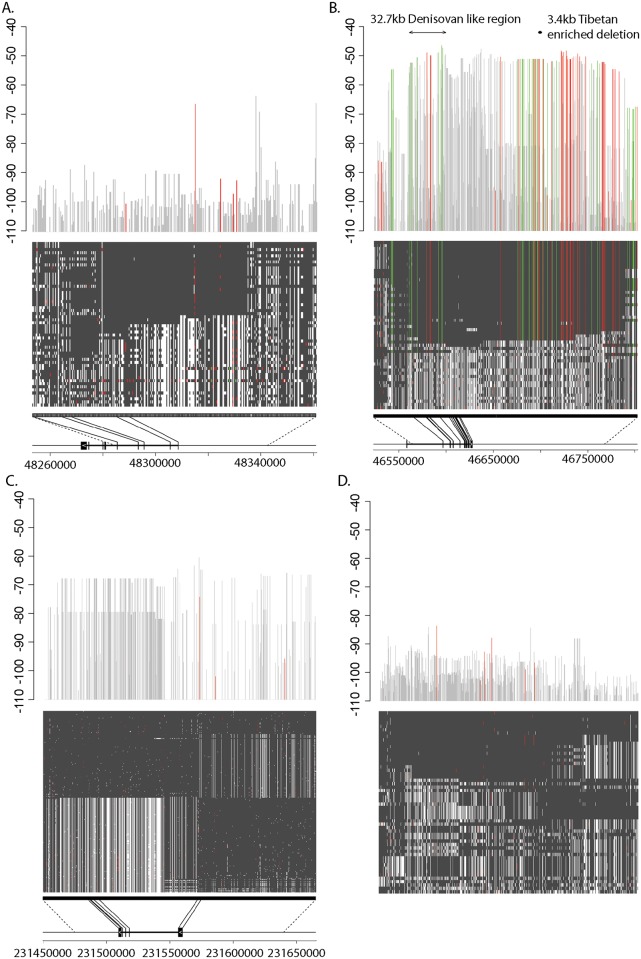
Haplotype map and CMS score in four genomic regions.The upper bar plot demonstrates the CMS values at each SNV. The middle plot shows the haplotype structure of 27 Tibetan genomes in the region; each row represents one genome and each column is one SNV aligned with its CMS score in the upper figure. Both red and green color indicates uncommon variants (MAF<5%) in Yoruba, Europeans, Native Americans and Asians; variants in green in addition must be in the high-coverage reference Denisovan genome. When applicable, the lower plot represents the gene model for the protein-coding gene in the region, with each vertical line representing one exon. a) VDR gene region (Chr12:48257328–48357328); b) EPAS1 gene region (Chr2: 46533376–46792633). The arrowed block above the bar plot indicates a previously identified 32.7kb region enriched for Denisovan variants; the dot above the bar plot indicates a previously identified deletion common in Tibetans (chr2: 46694276–46697683); c) EGLN1 gene region (Chr1: 231457651–231657496); d) a 200-kb genomic region that presumably underwent no positive selection (showing Chr21: 32800690–33000356, the 200-kb region with the median CMS score).